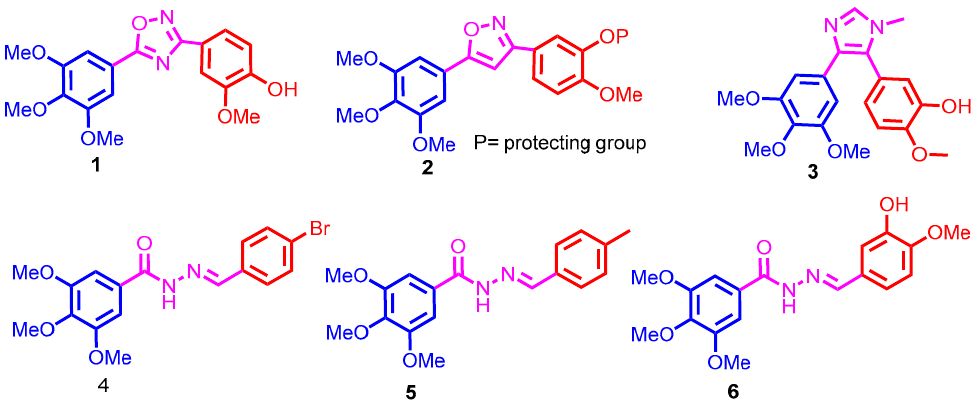
Figure 2. Structurally related CA-4 analouges.